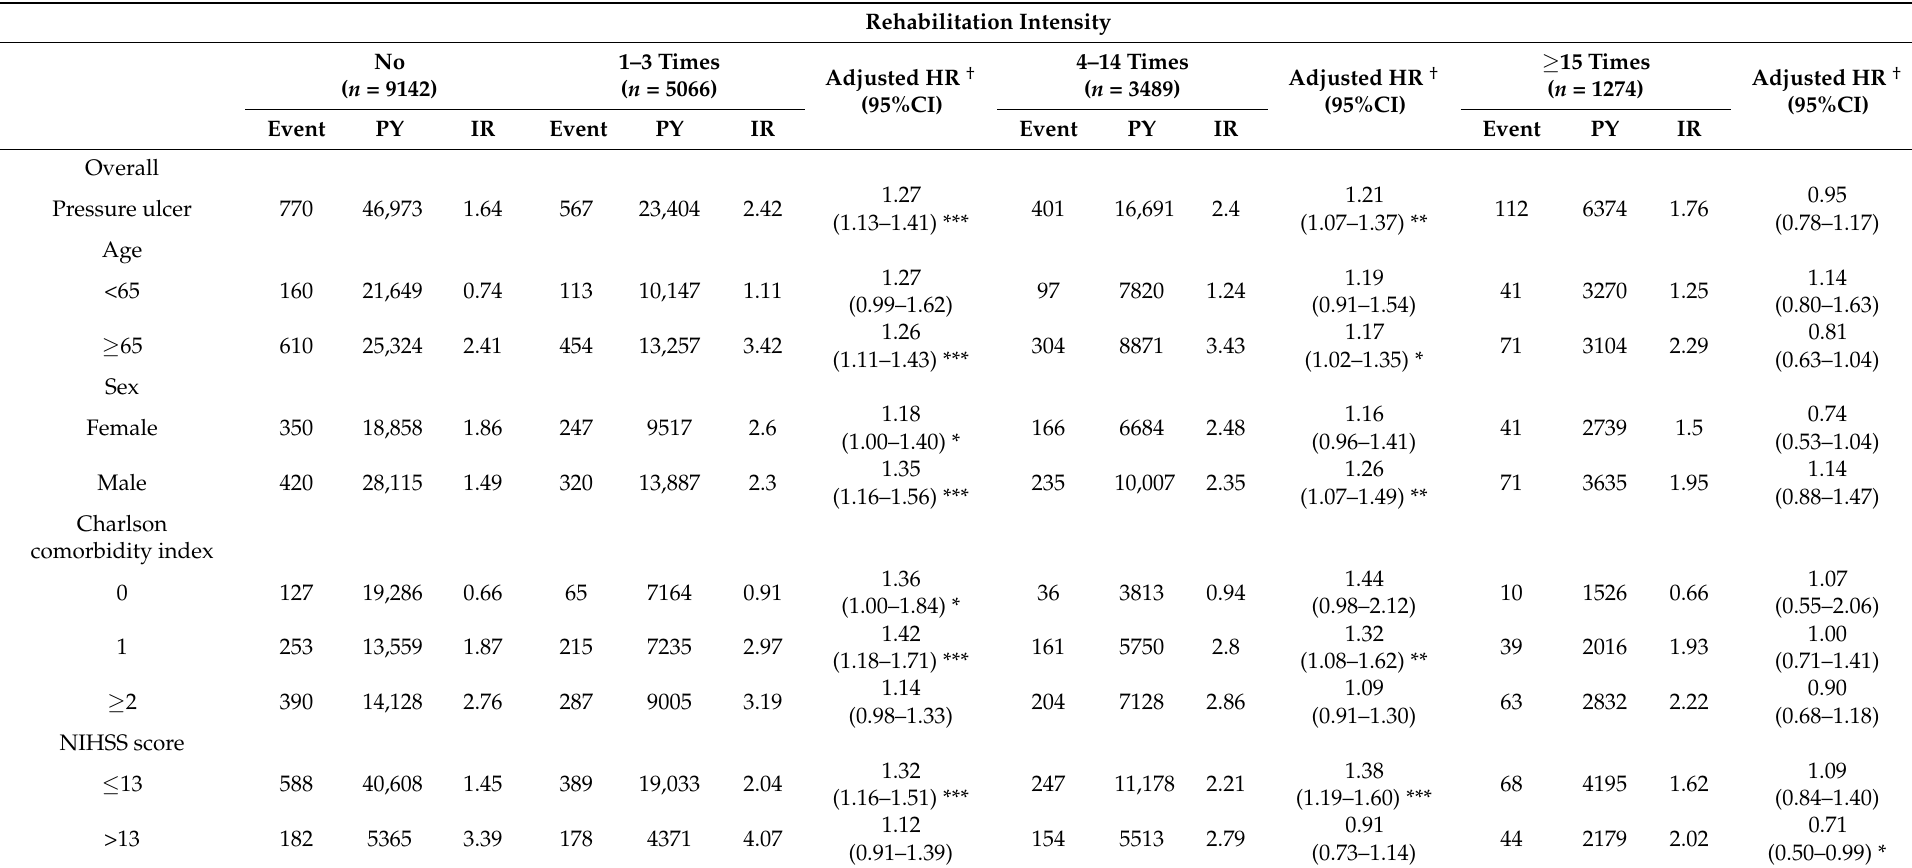
Table 2. Incidence rate and hazard ratio of pressure ulcer among four groups stratified by age, sex, Charlson comorbidity index, NIHSS score, hospital level, urbanization level, and residential area of